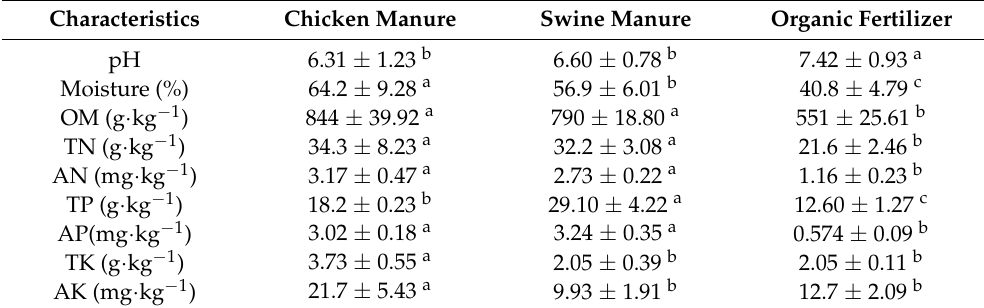
Table 1. The characteristics of chicken manure, swine manure, and organic fertilizer. Characteristics